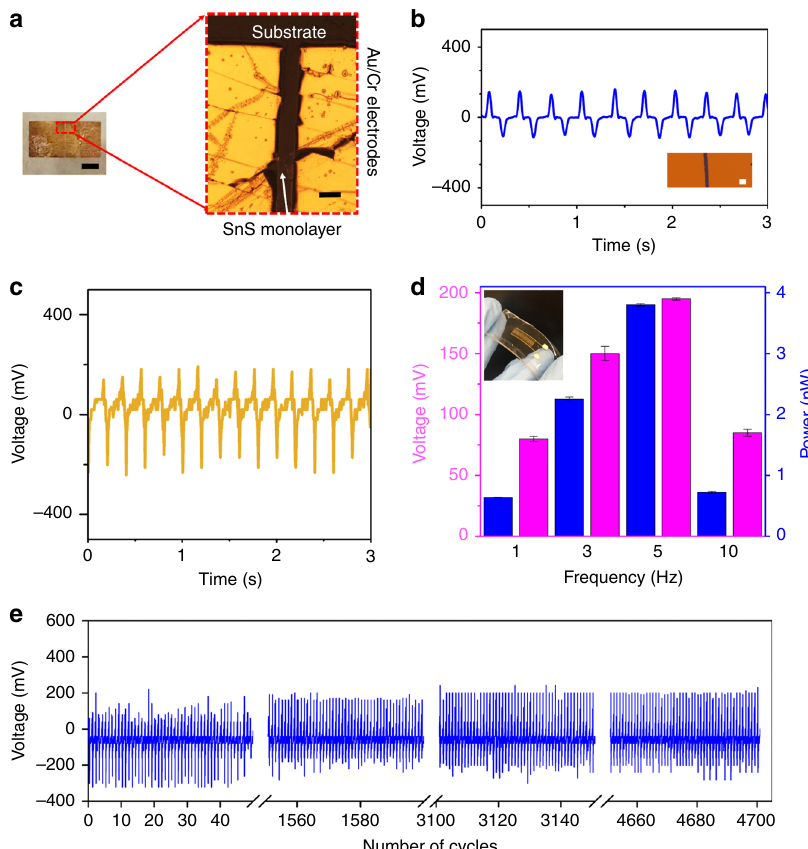
Fig. 4 The outputs of the devices with synthesised monolayer SnS using tapping mode to excite d 31 . a The optical image of the two-electrode device. Scale bars are 1 mm and 50 µ m for left and right images, respectively. b Response of the output voltage of the two-electrode device. Inset shows an optical image of the device. Scale bar is 50 µ m. c Response of the output voltage of the multi-electrode device excited at 5 Hz. d A graph showing the variation of average output power and voltage at varying tapping frequencies and inset is the photo of the PDMS-encapsulated mica fl exible nanogenerator (multi- electrode device). Error bars denote the standard deviation of the measurements. e Stability test of output voltage with stimulus applied at frequency 5 Hz for ~4700 cycles (multi-electrode